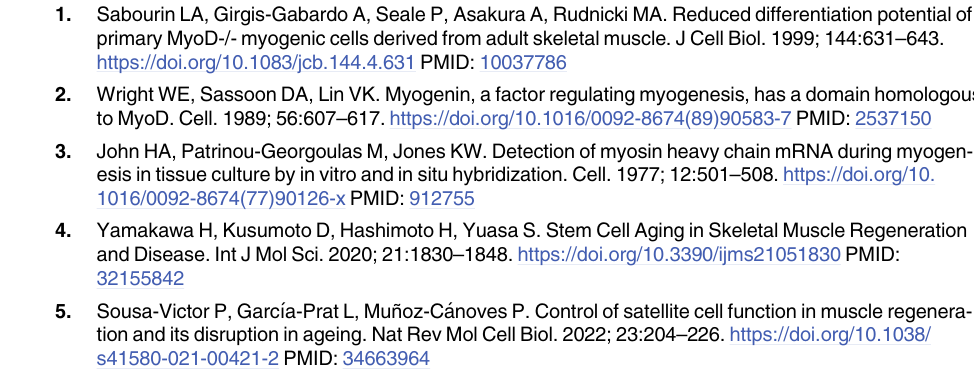
S1 Fig. Time course of miR-206 (panel A) and miR-133b (panel B) levels after changing the medium for myogenic differentiation. Myogenic differentiation was induced in cells subjected to passage once (passage 1). Data are presented as means ± SE (n = 4 dishes). (TIF) S2 Fig. The miR-1 (panel A) and miR-133a (panel B) expression levels in replicative senescent C2C12 cells transfected with miRNA mimic. Cells subjected to passage 10 times were trans- fected with miR-1, miR-133a, or both and collected before the induction of differentiation for miRNA quantitation. Mock cells were transfected with a negative control miRNA. Data are presented as means ± SE (n = 4 dishes). �� P < 0.01 vs. mock (Dunnett 0 s test). (TIF) S1 Raw images. Raw images of western blots for Figs 1, 3, 5 and